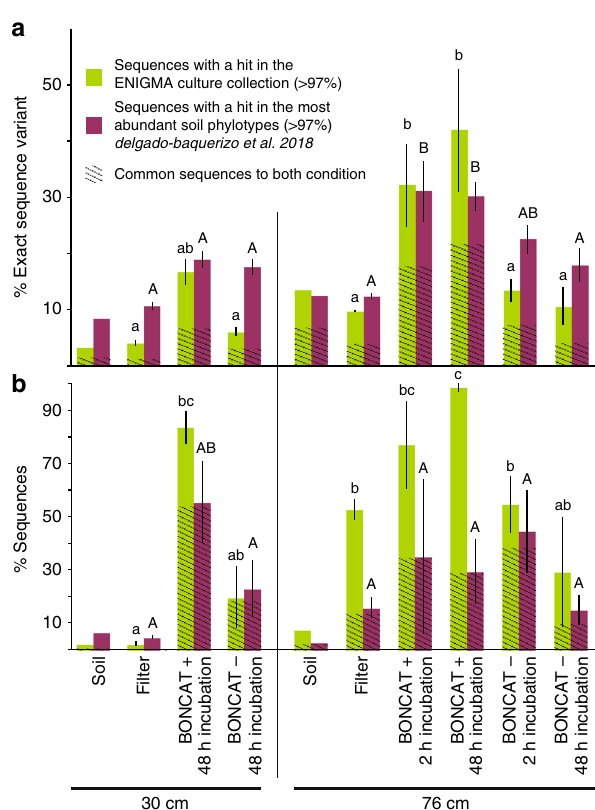
Fig. 4 Prevalence of soil isolates and ubiquitous soil OTUs among BONCAT + cells. a Percent features (non-clustered DADA2 results) and b percent sequences from the current libraries with a hit (>97% sequence similarity) in the ENIGMA culture collection (this collection contains 697 full-length 16S rRNA gene from strains that were isolated from the same fi eld site as the samples considered in this study) (green), in the set of 511 phylotypes identi fi ed as the most abundant by 29 (yellow) or both (dashed area). Data are average ( n = 3) ± SD, letters indicate ANOVA post hoc signi fi cant differences. “ soil ” samples are libraries constructed from total DNA extracted from soil, “ fi lter ” samples are DNA extracted from all cells detached from soil and captured on a 0.2 µ m fi lter, BONCAT + and BONCAT- libraries were constructed from corresponding cell sorted